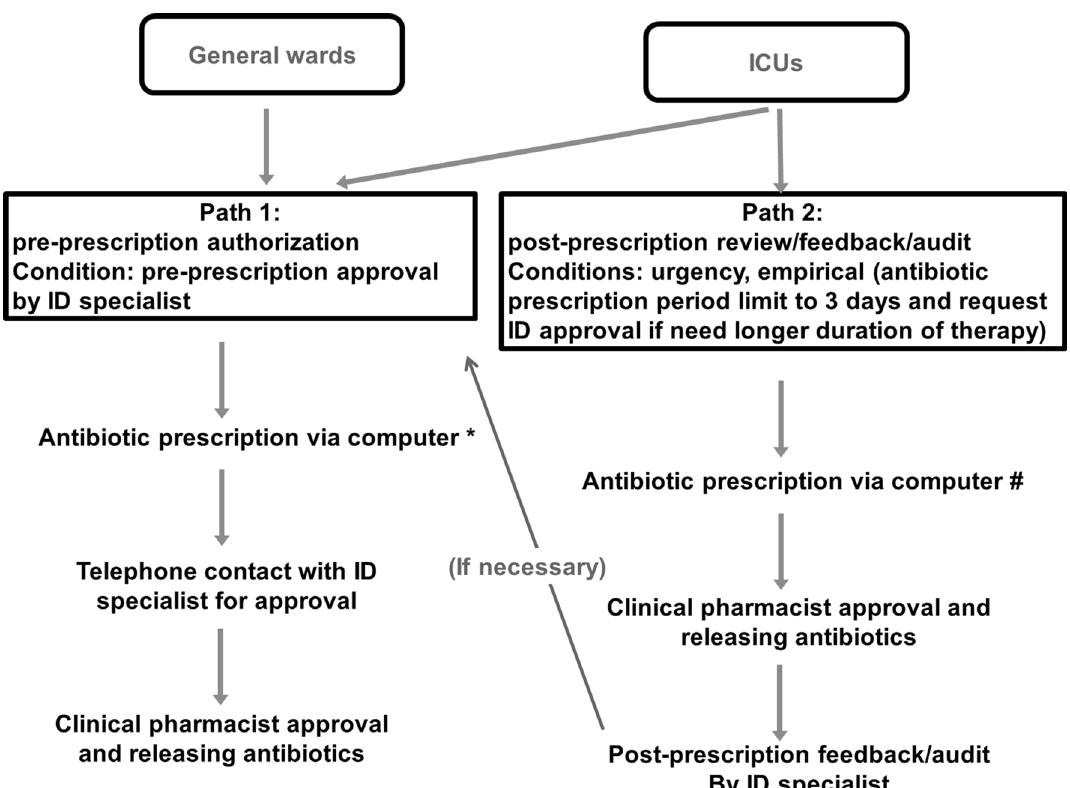
Figure 1. Flow chart for the restrictive antimicrobial prescription protocol. *The default duration of antibiotics prescription was 3 days for empiric therapy and 7 days for definite therapy. # The default duration of antibiotics prescription was 3 days for cases requiring urgent treatment in the intensive care unit (ICU). ID infectious